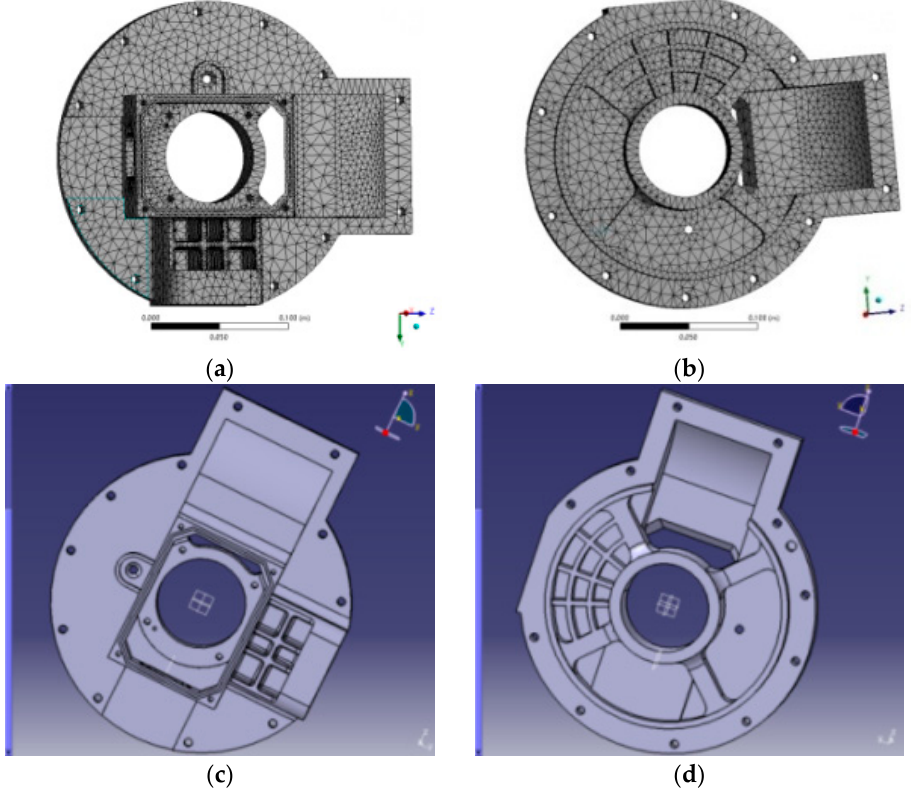
Figure 5. CAD and FEM model of the optimised product. ( a ) FEM model of side A ( b ) FEM model of side B ( c ) CAD model of side A ( d ) CAD model of side B.